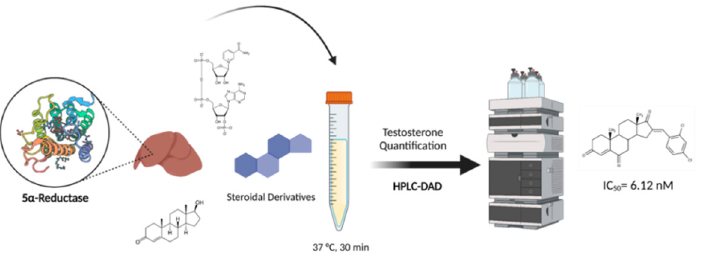
Figure 1. Methodology for the 5 α -reductase inhibitory capacity evaluation of a series of novel steroidal arylidene derivatives using HPLC-DA. Created with BioRender.com.